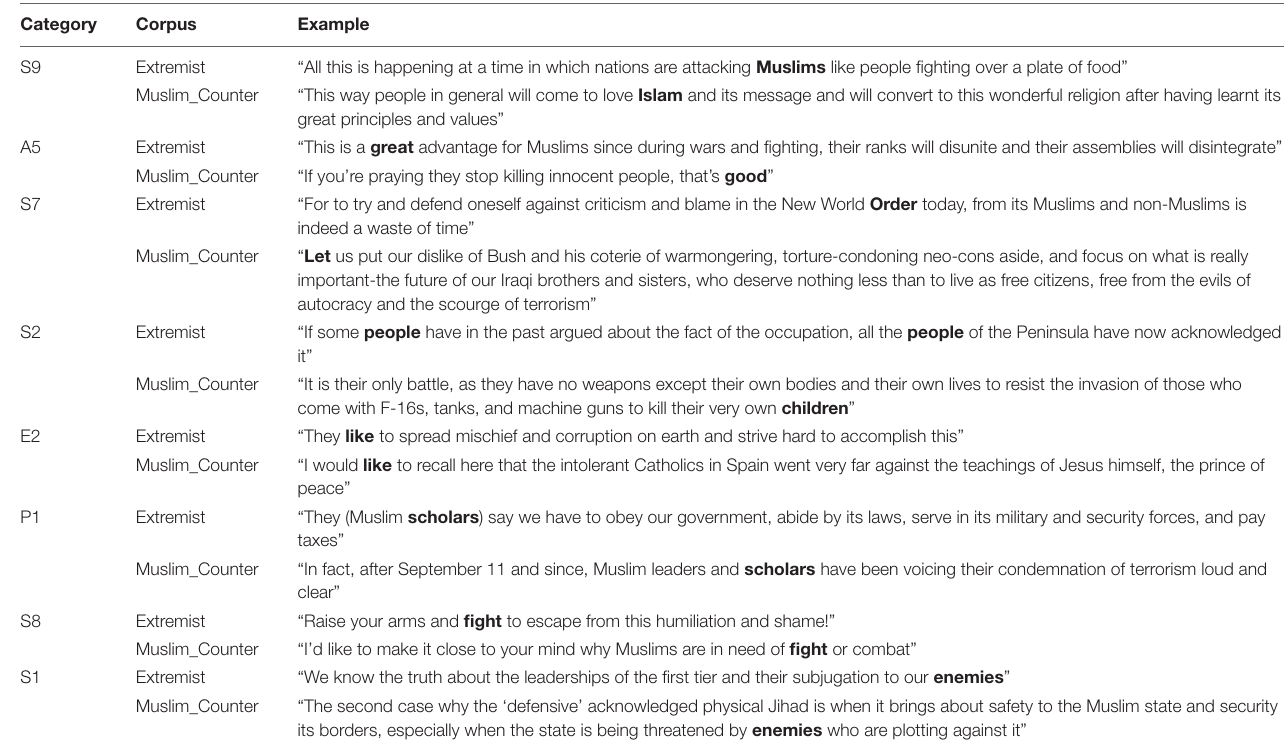
TABLE 2 | Examples of shared conceptual categories between Salafi Jihadist/Related messages (Extremist) and religious authored counter-extremist messages (Muslim_Counter). Category